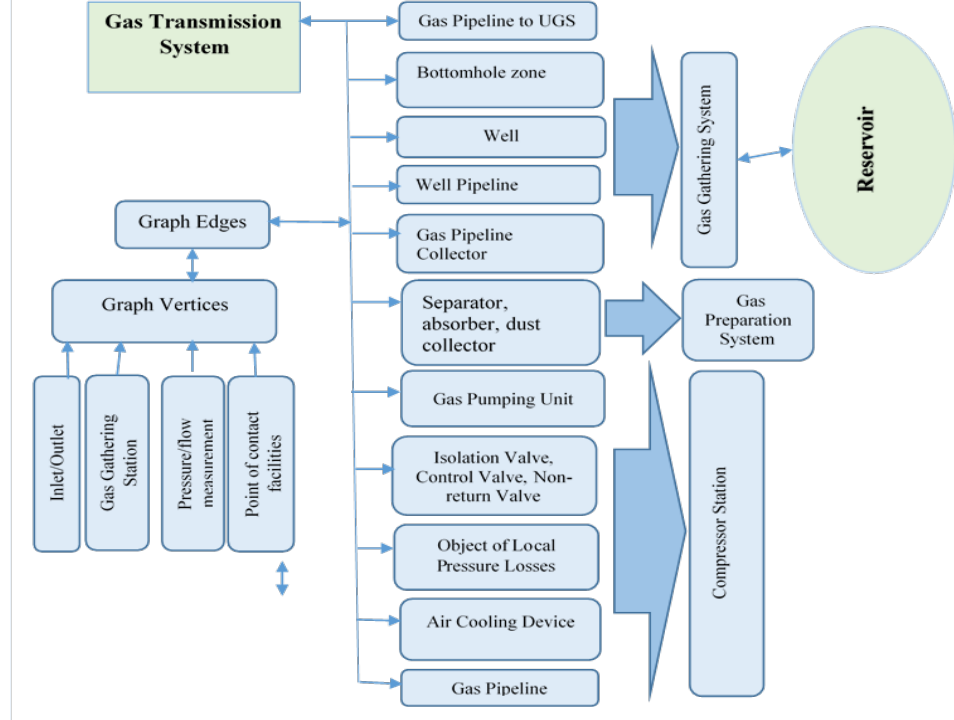
Figure 4. Objects of the structural model of underground gas storage.